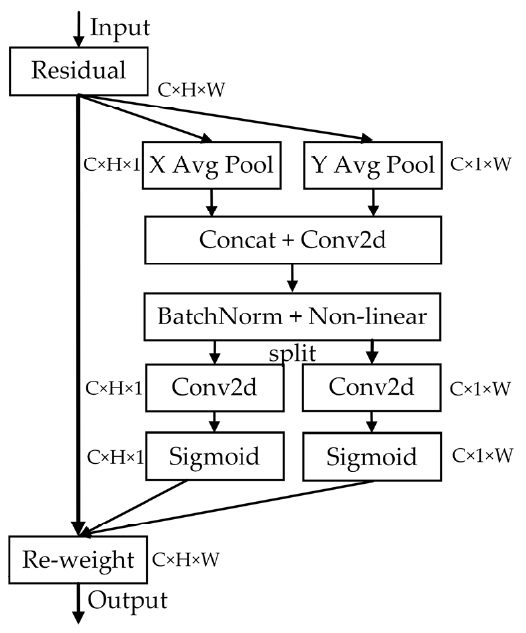
Figure 8. Structure of the Coordinate Attention Module.